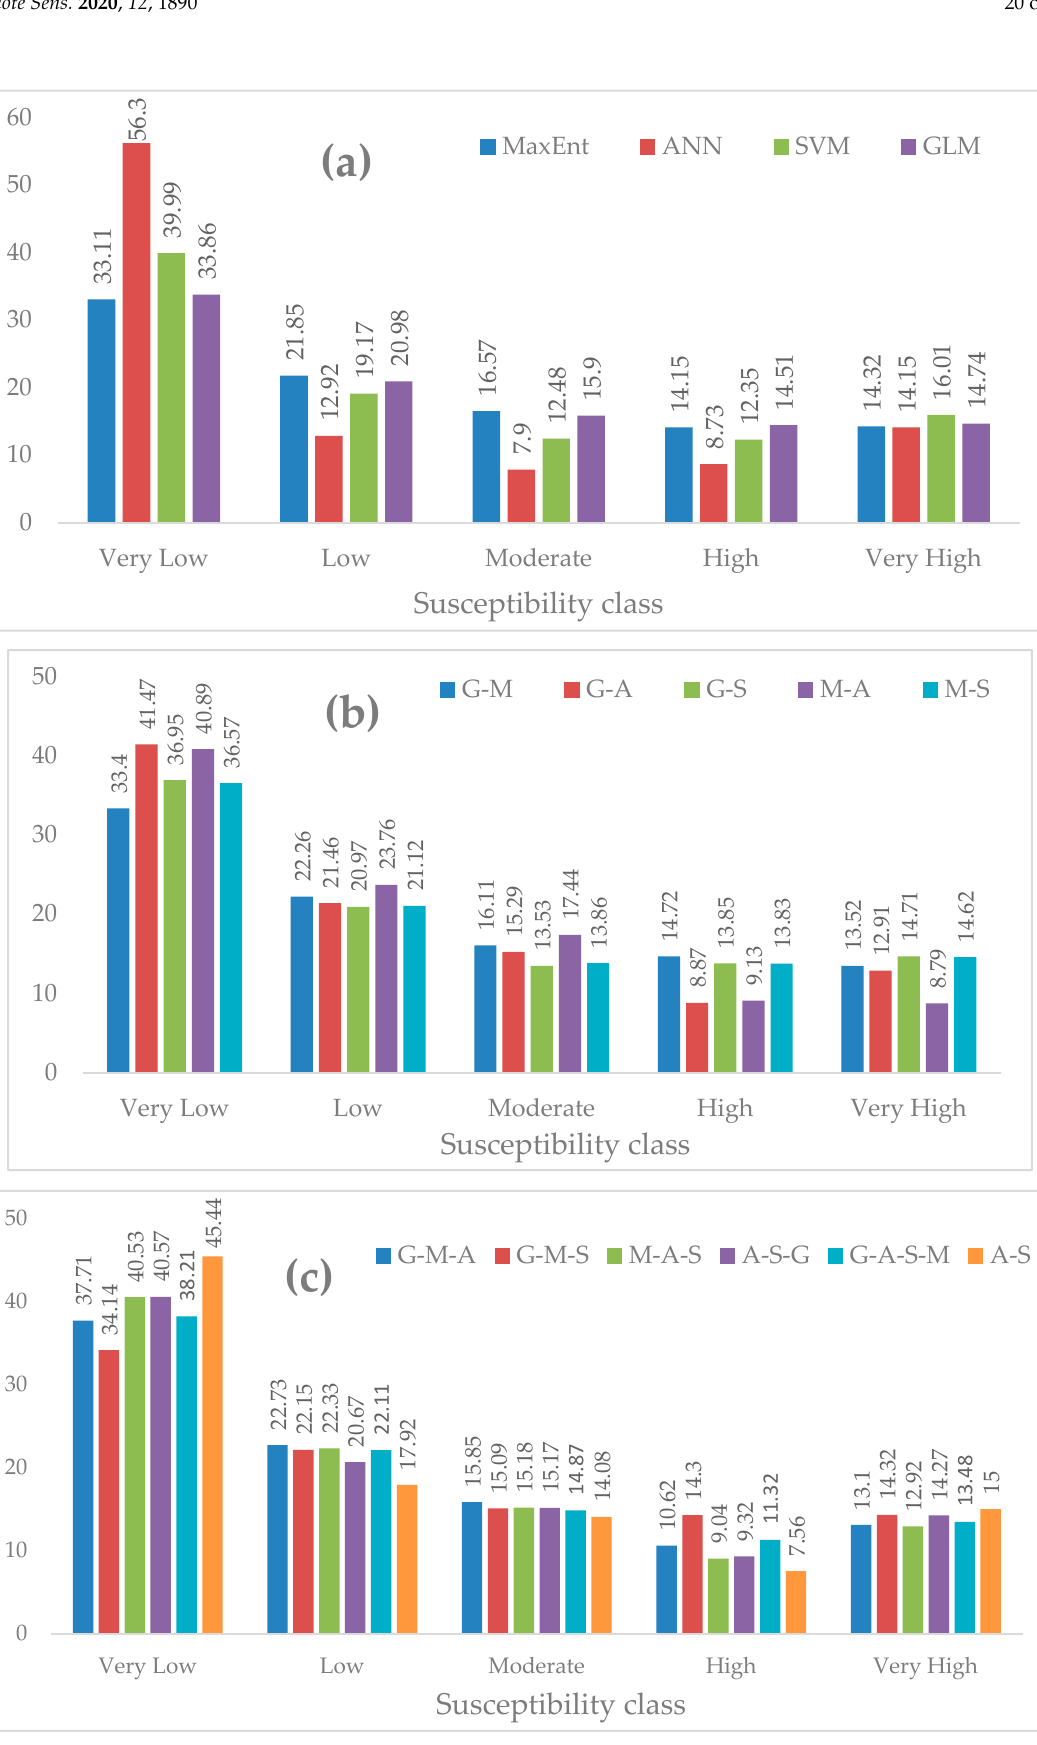
Figure 10. Percentage of each susceptibility class. ( a ) individual models, ( b ) ensemble of two models, and ( c ) ensemble of three and four ensemble models.